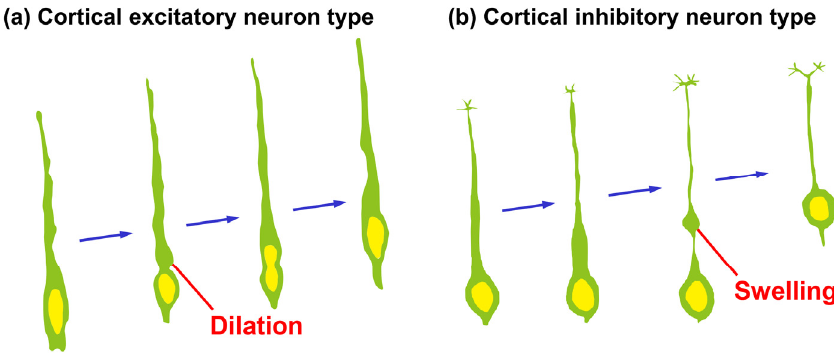
Figure 2. Morphological changes of leading processes of migrating neurons. ( a ) Cortical projection neurons extend a leading process and form a cytoplasmic “dilation” at the proximal region of a leading process, and the nucleus in the locomoting neurons becomes elongated to enter the cytoplasmic dilation; ( b ) Cortical interneurons extend a leading process, a cytoplasmic swelling is formed at the relatively distal region of the process and subsequently the nucleus enters the cytoplasmic swelling.